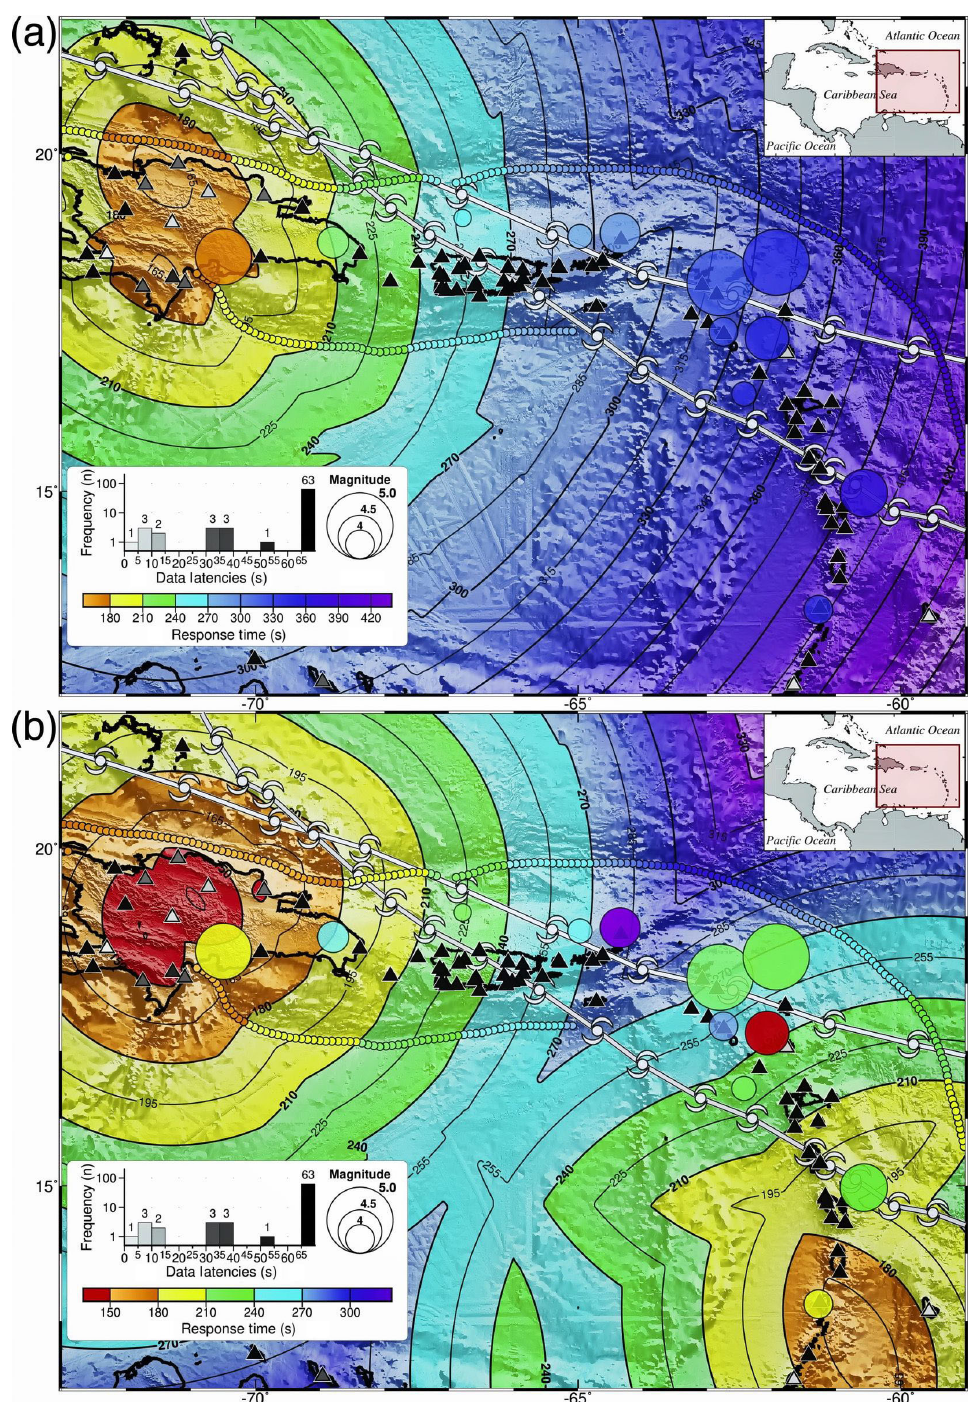
Figure 10. Theoretical response times within the eastern Caribbean region monitored by the PTWC after accounting for the impact of hur- ricanes Irma and Maria. Response times obtained by (a) adding 110s to the detection times of the first arriving S wave at the closest five stations, namely Fig. 10a = (Fig. 6b + 110) and (b) adding 110s to the detection times of the first arriving S wave at the closest two sta- tions applying the operation Fig. 10b = (Fig. 2b + Fig. 8b + 110). The diameter of the circles indicates the catalog magnitude for 12 local earthquakes processed by PTWC between 12 September 2017 and 7 January 2018, while their color indicates (a) the theoretical response times read directly from the map and (b) the actual PTWC response times for the 12 earthquakes. The small, contiguous circles illustrate the computed response times sampled every 10km along the trench axes. White vortex tracks show the paths of hurricanes Irma to the north and Maria to the